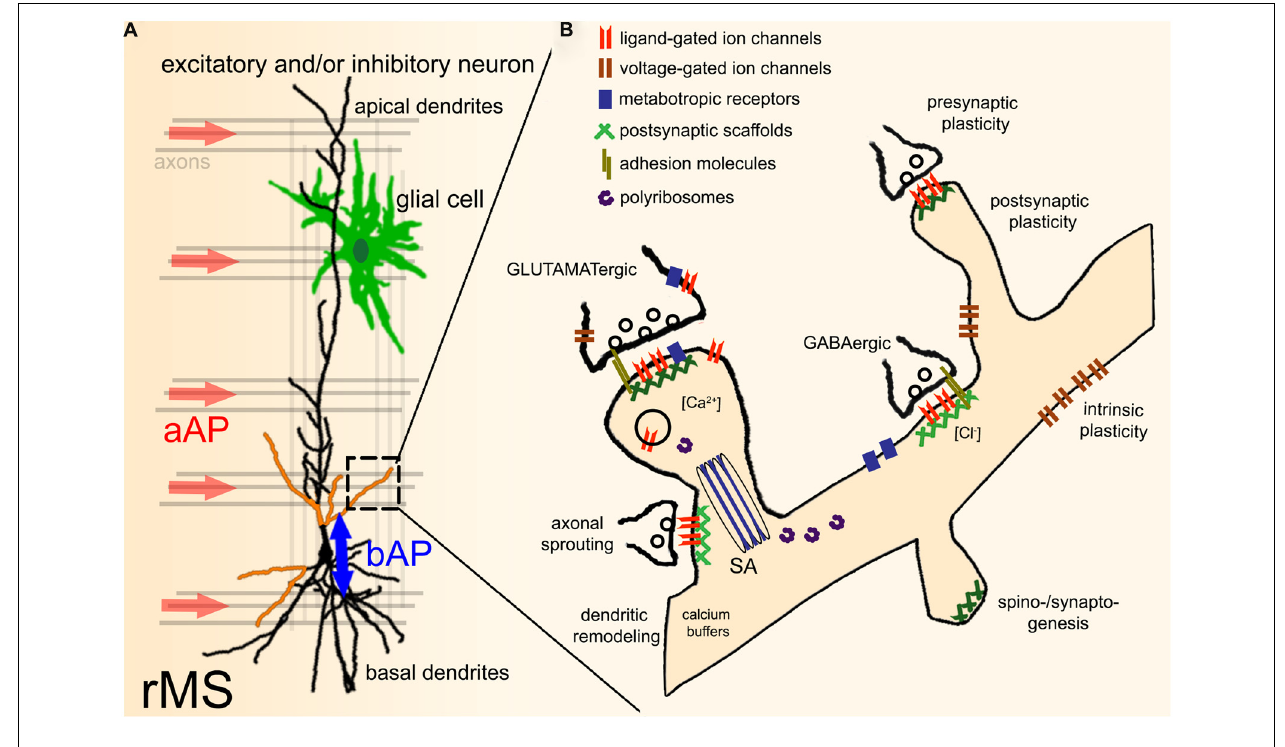
neural structures, e.g., glial cells (astrocytes, microglia, oligodendrocytes) have not been investigated so far.The role of local circuits (e.g., recurrent networks, feed-forward, and feed-back inhibition) needs to be determined in this context as well. (B) Illustration of potential direct or indirect molecular targets of rTMS. For further details please see text [SA, spine apparatus organelle (Gray, 1959; Spacek,